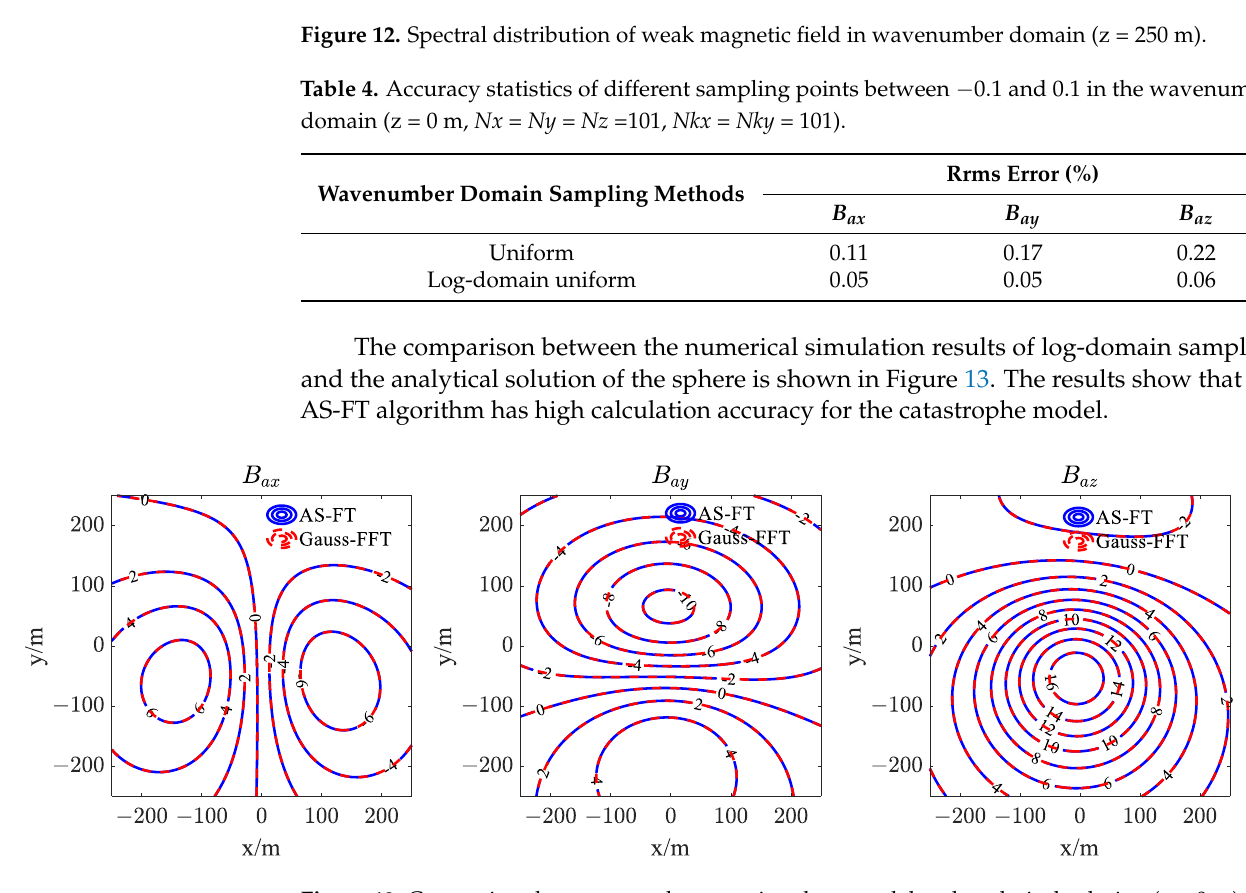
Figure 13. Comparison between weak magnetic sphere model and analytical solution (z = 0 m).